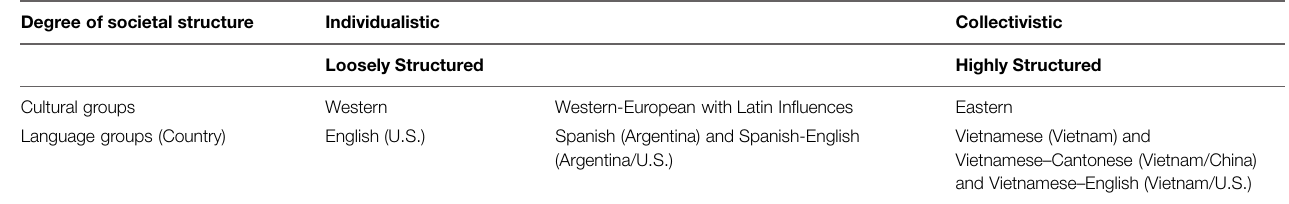
TABLE 1 | Spectrum of the degrees of collectiveness among different cultures.